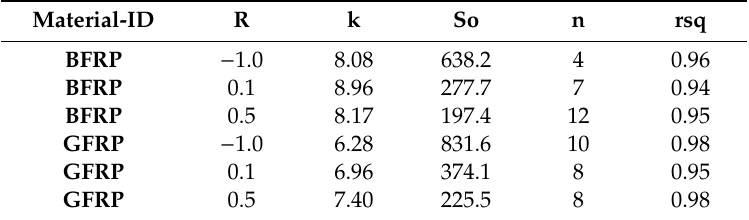
Table A3. Parameters of the SN curves of BFRP and GFRP—For a Basquin’s fitting of log Sa = log So − 1 / k*logN.